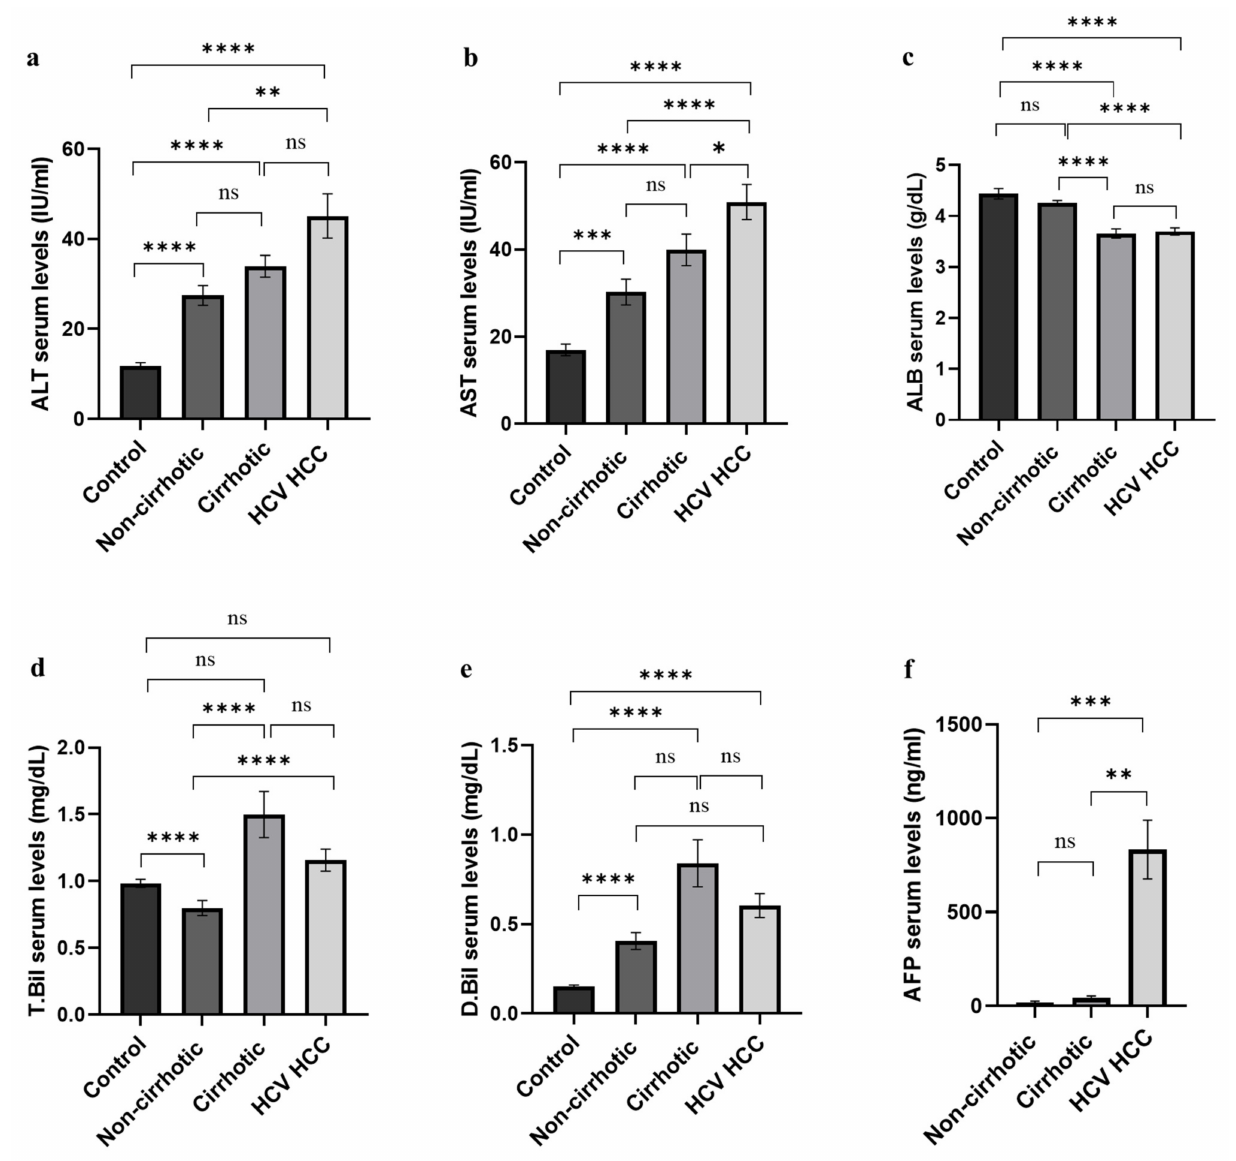
Figure 3. Mean of serum concentration of liver biomarkers in the study groups. ( a ) Comparison of mean values of ( a ) ALT, ( b ) AST, ( c ) albumin, ( d ) total bilirubin, ( e ) direct bilirubin, and ( f ) AFP. Values are expressed as mean ± SEM. Statistical significance (**** indicates p ≤ 0.0001, *** indicates p ≤ 0.001, ** indicates p ≤ 0.01, * indicates p ≤ 0.05, “ns” indicates statistically non-significance). (AFP: alpha-fetoprotein, ALB: albumin, ALT: alanine aminotransferase, AST: aspartate aminotransferase, D. Bil: direct bilirubin, T. Bil: total